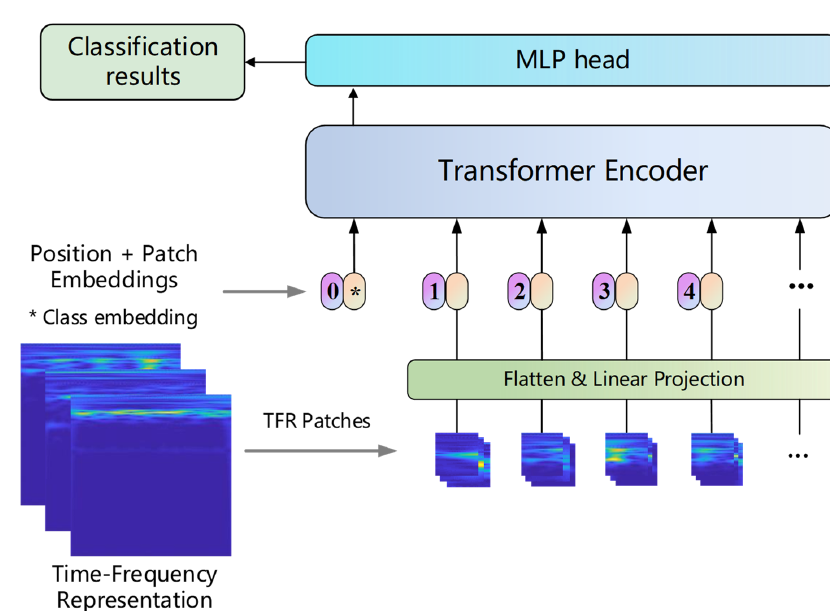
Figure 4. Framework of the ViT model.